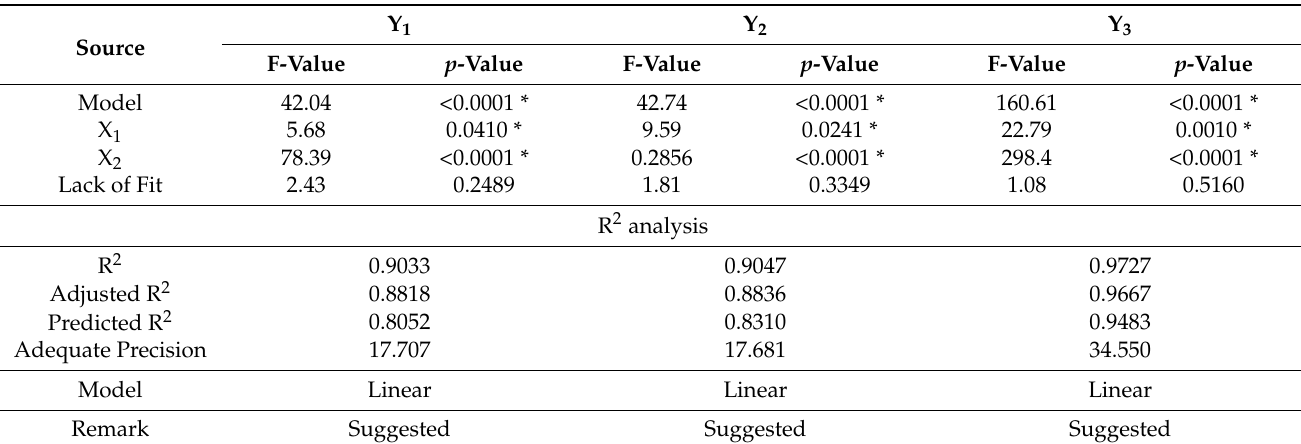
Table 2. Statistical and regression analysis results for all